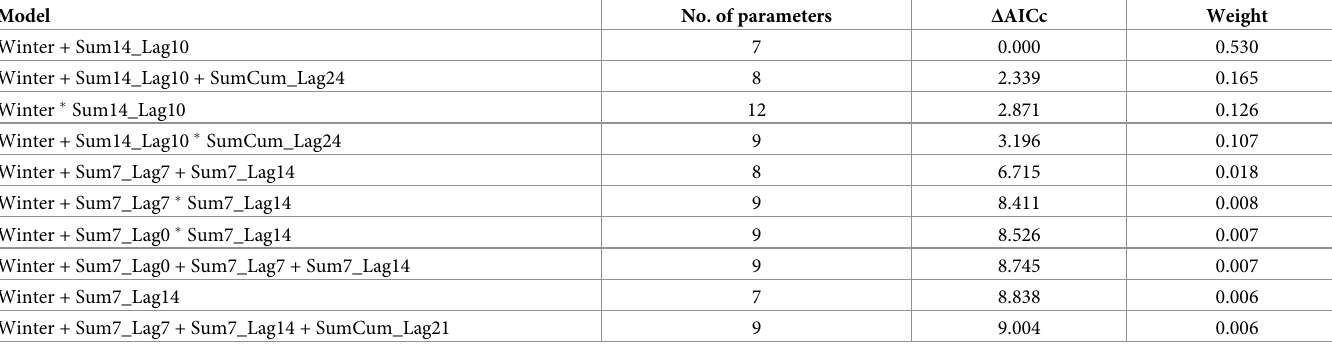
Table 4. Top 10 models for 7-day counts of cold-related manatee carcasses reported in the central-west region based on air temperature. Model No. of parameters Δ AICc